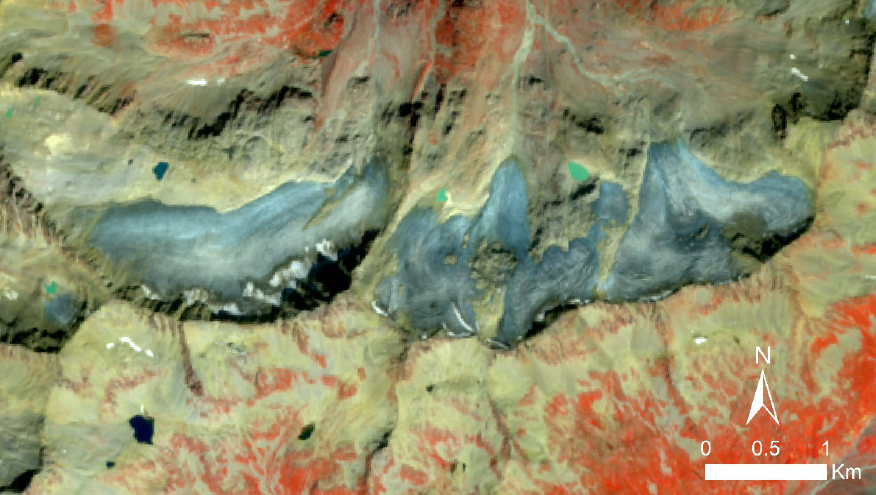
Figure 12 . Khasankoi glaciers (north-western Greater Caucasus) during the late summer without snowlines. Sentinel 2B image (04/09/2020) is used as a background.